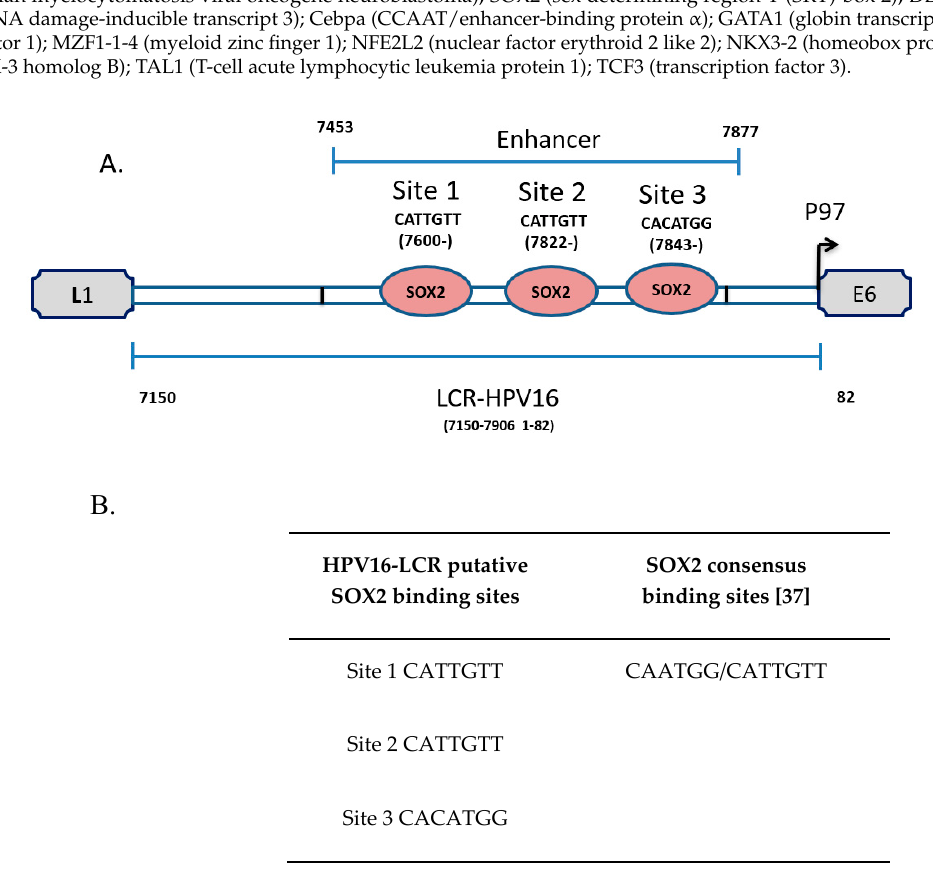
Figure 1. The LCR enhancer region of HPV16 contains sex determining region Y (SRY)-box 2 (SOX2) binding sites. ( A ) The nucleotide positions of the identified putative SOX2 binding sites (Site 1, Site 2 and Site 3) on the LCR enhancer region are shown; ( B ) Comparison of putative SOX2 binding sites to the reported SOX2 consensus sequences [37].